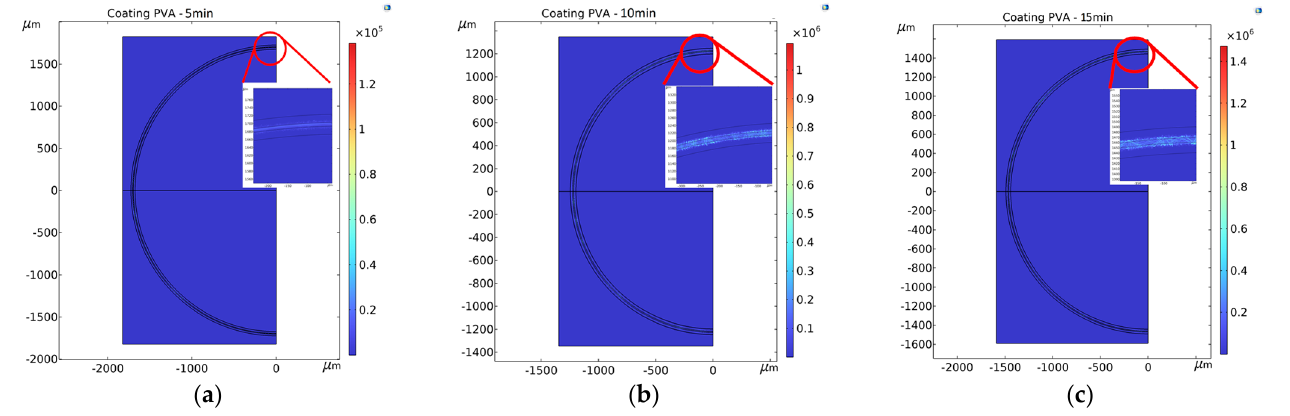
Figure 8. Energy fields simulated in COMSOL for sensors with electrospinning durations of ( a ) 5